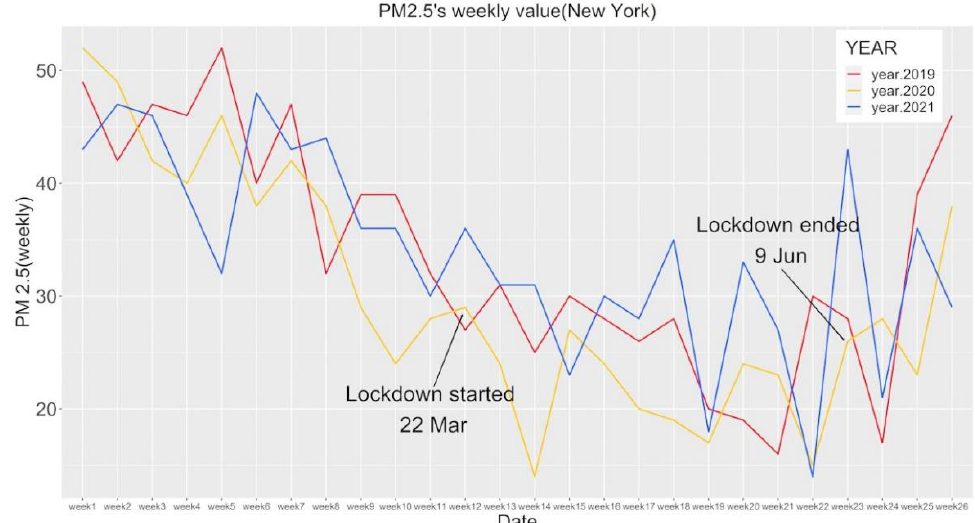
Figure 2. Weekly PM2.5 value (New York).